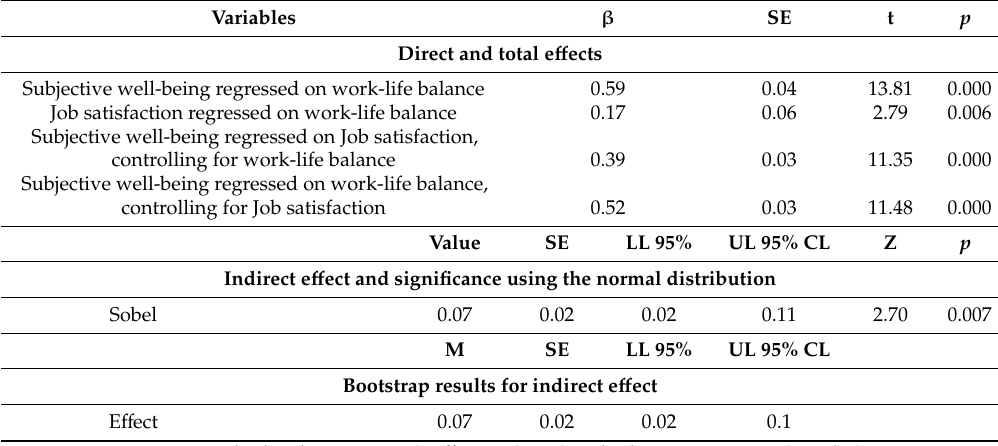
Table 6. Regression Results for Simple